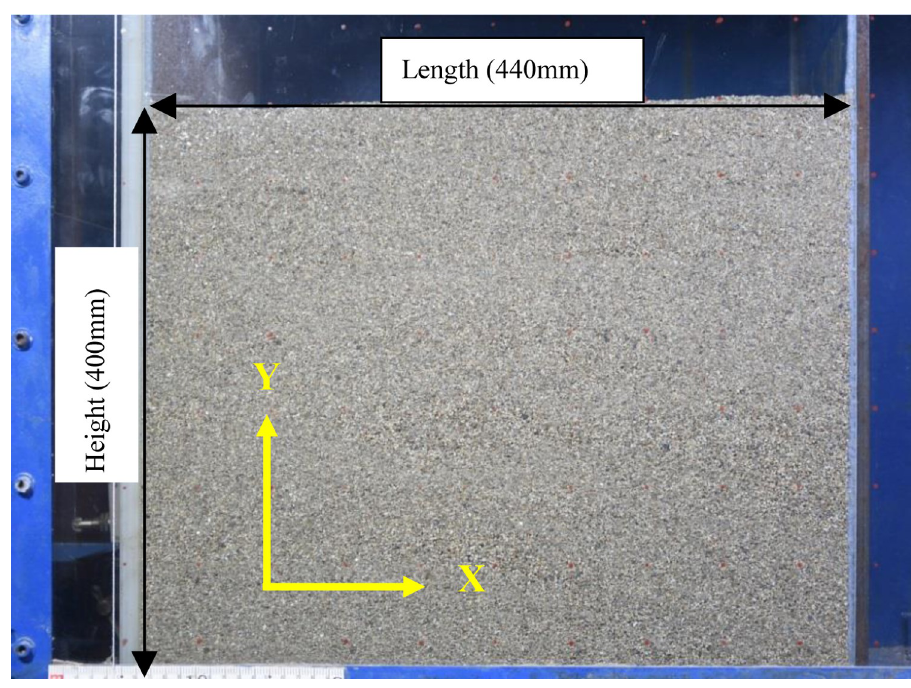
Fig 4. Sand sample in soil box.